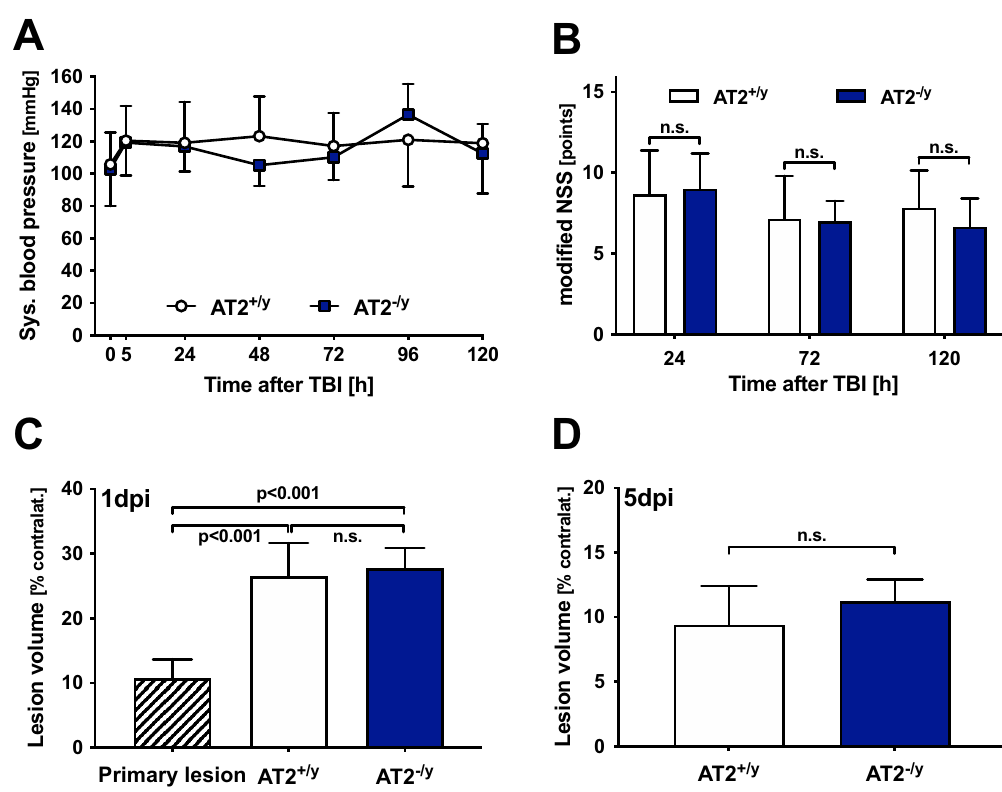
Figure 3. AT2 deficiency does not affect the blood pressure, neurological outcome and the lesion volume: AT2-deficient mice (AT2 −/y ; 24 h: n = 12; 5 days: n = 6; blue) were compared to age-matched WT mice (AT2 +/y ; 24 h: n = 12; 5 days: n = 6; white). The values are presented in mean ± SD; n.s. = not significant. ( A ) Peritraumatic systolic blood pressure: time point 0 represents the intraoperative measurement immediately after CCI under general anesthesia, and the following postoperative time points measurements were performed in awake animals. The values were within the physiological norms and did not differ between the AT2 −/y and AT2 +/y animals. ( B ) The mNSS after CCI was not significantly different between the AT2 −/y and AT2 +/y animals. ( C ) , ( D ) Cerebral lesion volume (to rule out effects of edema, data are expressed as % contralateral hemisphere): primary lesion was assessed 15 min after TBI, without difference between AT2 +/y and AT2 −/y animals. C: The marked secondary increase of lesion volume 24 after TBI (1 day post-injury, 1dpi; p < 0.001) was not different in AT2 +/y mice compared to AT2 −/y mice. ( D ): Five days after TBI (5dpi), there was no difference in the lesion volumes between the AT2 +/y and AT2 −/y